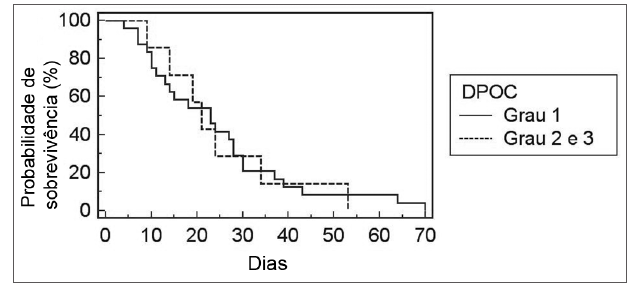
Figura 3. Relação entre DPOC e tempo de internação